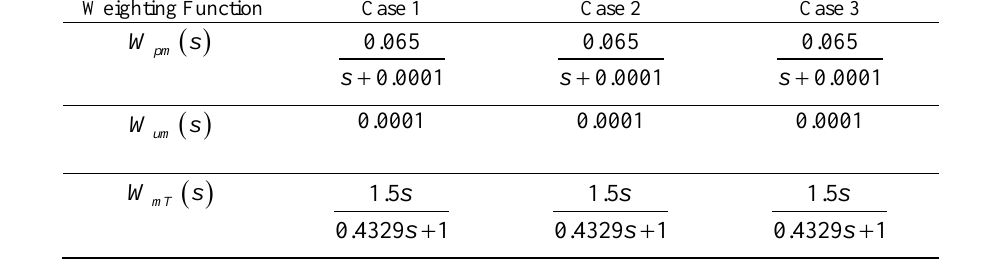
Table 4. Local controllers